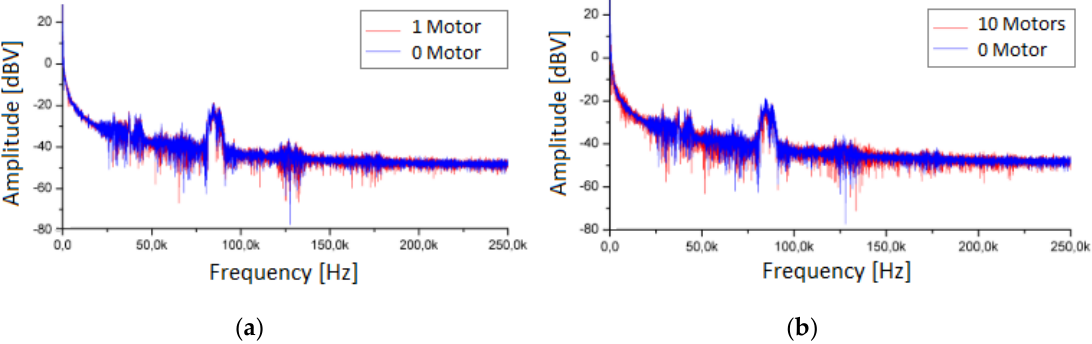
Figure 1. Spectrums of frequencies in the PLC window: ( a ) white noise of the network and the one motor noise; and ( b ) white noise and ten motors noise.